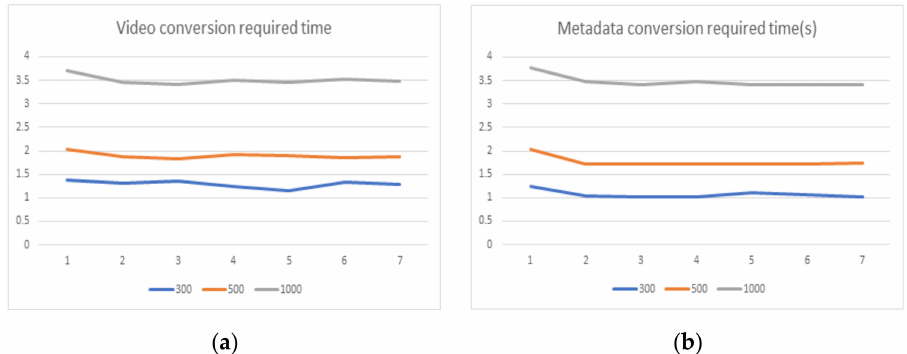
Figure 11. Time required for the proposed mechanisms: ( a ) time required for video conversion, ( b ) time required for metadata